Question: Does the figure show an increasing or a decreasing trend?
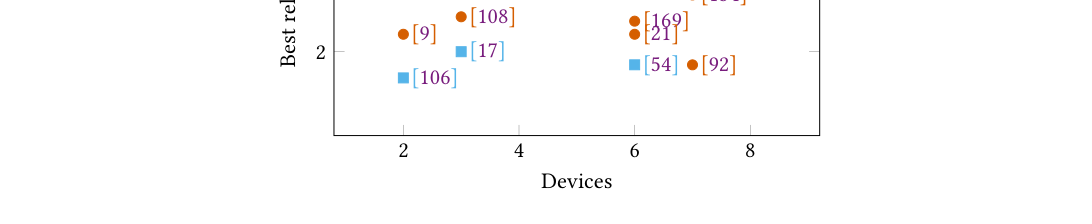
Answer: increasing